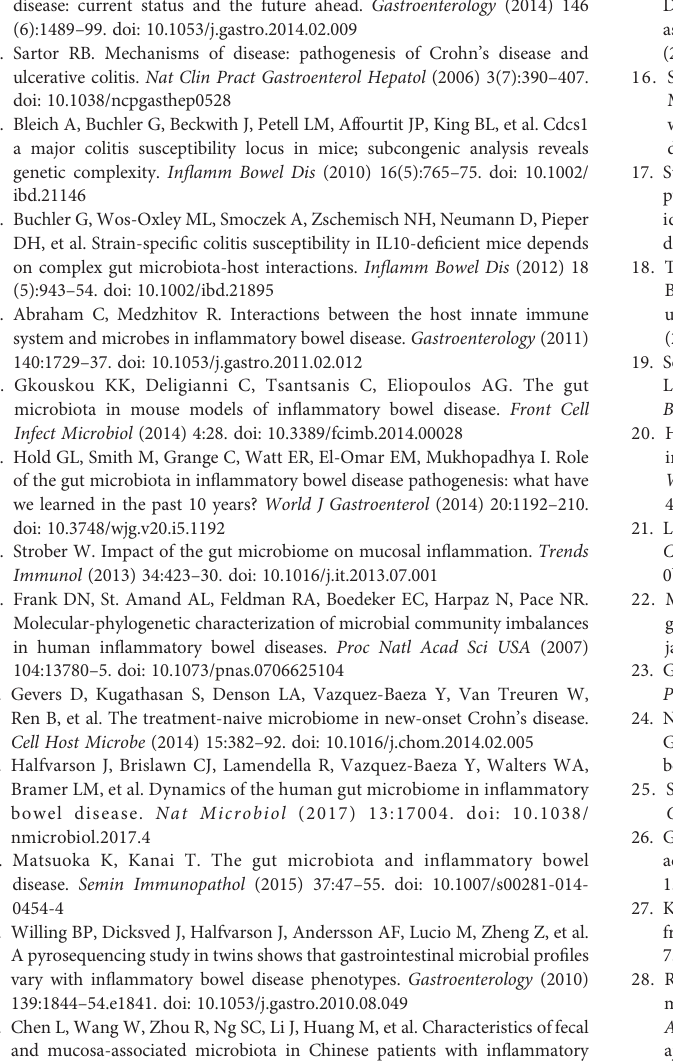
throughoutthestudy. (B and D) .The%abundanceofspeci fi cbacterialgenerafrom WT and IL-10 -/- mice are shown by the colored lines and identi fi ed by the key. (C and E) . Tables list speci fi c genera with statistically signi fi cant changes in abundance over the course of the study from WT and IL-10 -/- mice. The relative abundance (%) for each group is shown and p-values are shown parenthetically. The number of mice used for each strain at each time point varied as follows: at 4 weeks of age, n = 5; at 7 weeks of age, n = 10; at 10 weeks of age, n = 9; at 12 weeks of age, n = 13; at 19 weeks of age, n = 5. Supplementary Table 1 | (A) LefSE scores for differentially abundant gene families from PICRUSt analysis. Functional categories andLefSE scoresfor WTmice. The number of mice used for each strain at each time point varied as follows: at 4 weeksofage,n=5;at7weeksofage,n=10;at10weeksofage,n=9;at12weeks of age, n = 13; at 19 weeks of age, n = 5. (B) LefSE scoresfor differentially abundant gene families from PICRUSt analysis. Functional categories and LefSE scores for IL-10 -/- mice. The number of mice used for each strain at each time point varied as follows:at4weeksofage,n=5;at7weeksofage,n=10;at10weeksofage,n=9; at 12 weeks of age, n = 13; at 19 weeks of age, n =